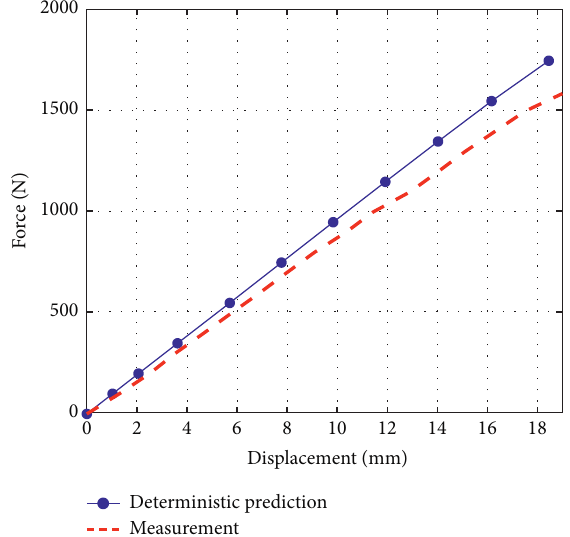
Figure 11: Comparison of the measured displacement-force curve with the deterministic prediction. Cohesive damage index 0.000 E + 00